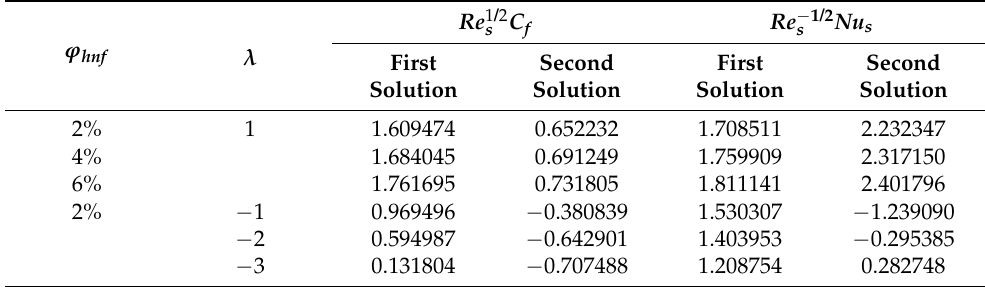
Table 4. Values of Re 1/2 s C f and Re − 1/2 s